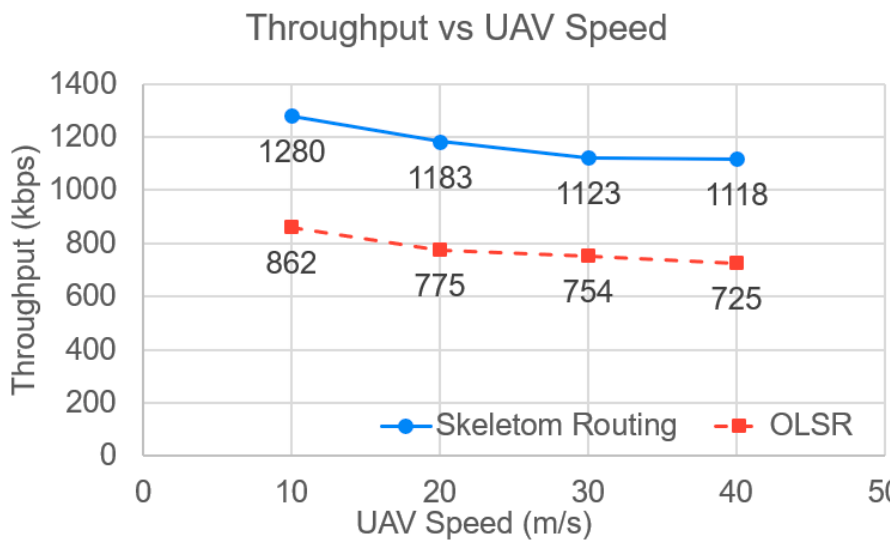
Figure 22. Throughput results with varying node speeds.